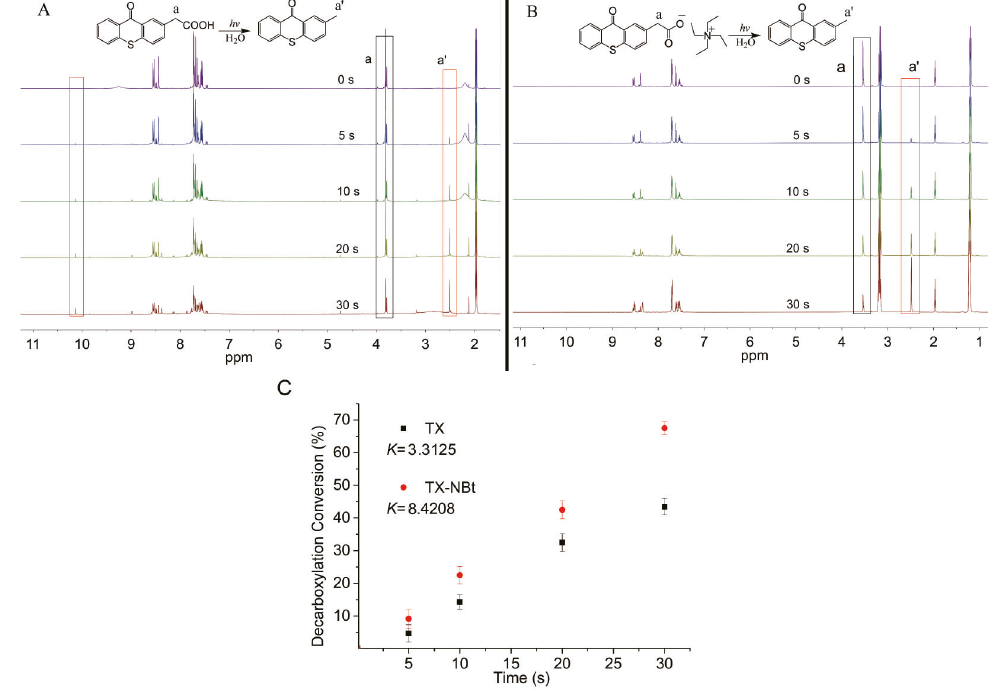
Figure 3. Photodecarboxylation 1 H NMR spectra (CD 3 CN) of TX ( A ) and TX–NEt ( B ) under an LED lamp with an output power of 1.1 W/cm 2 ; decarboxylation conversion (DC) of TX and TX–NEt under irradiation ( C ). K stands for NMR-observed rate constants [34]. DC was calculated by the integration area of methylene at 3.6